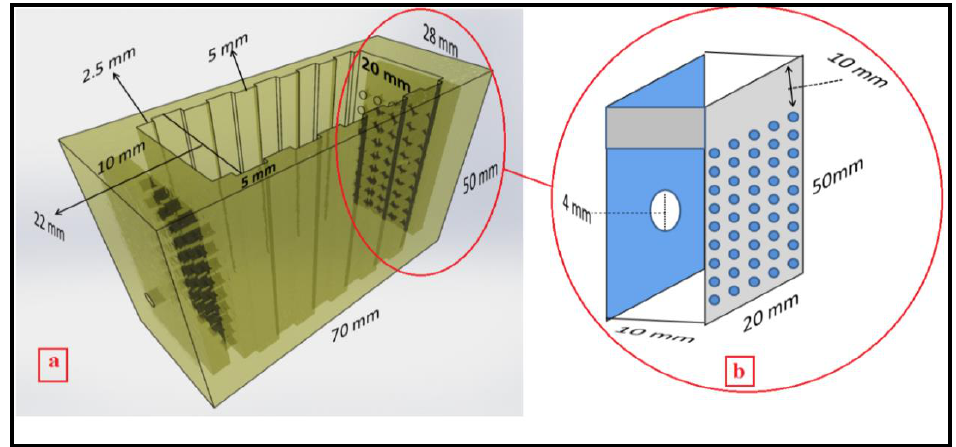
Figure 2. Schematic of a flow-through cell ( a ) and cross-section of flow-distributor chamber ( b ).